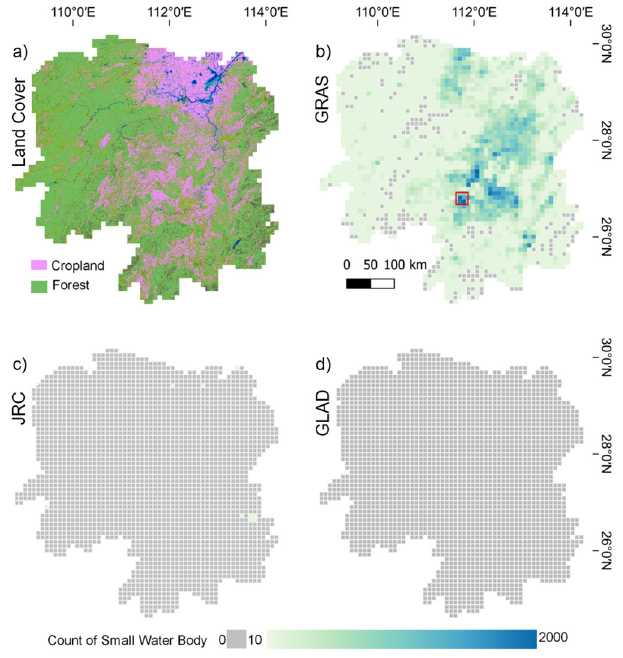
Figure 10. Land cover distribution [83] (a) and counts of small water bodies (<0.81 ha) within 10×10 km grid cells over Hunan province by GRAS-SWD (b); JRC-GSWE (c) and GLAD-GSWD (d).